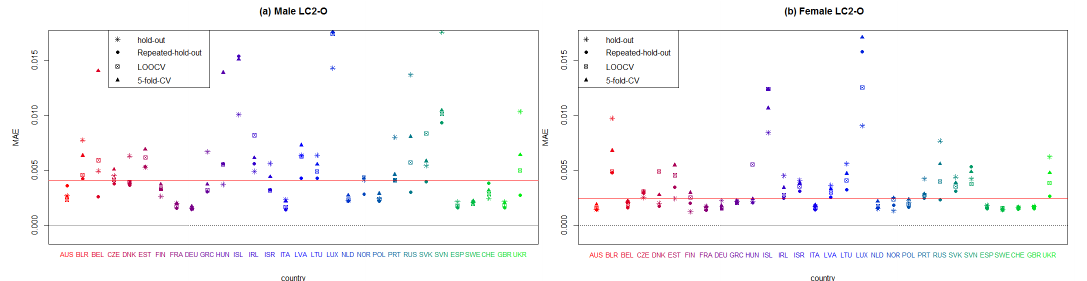
Figure A6. Plot summarizing the mean absolute measure (MAE) of each European country that applies bifactorial Lee–Carter model with orthogonalized parameters to males and females, according to every employed resampling